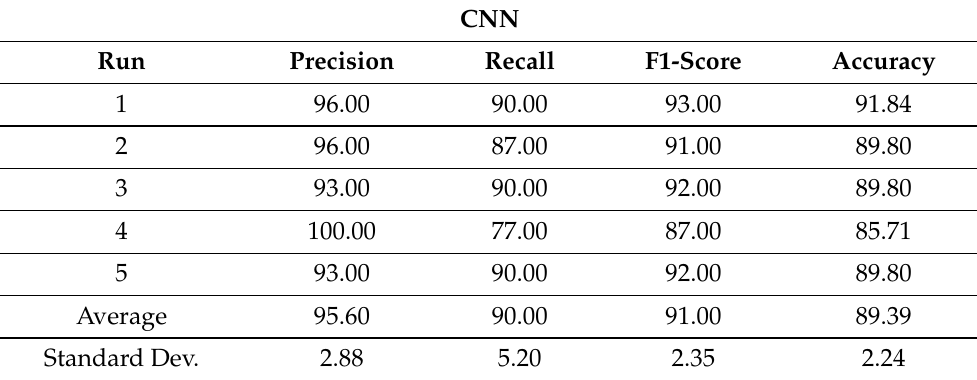
Table 7. Summary of the results obtained with the 1-D CNN model. We collect the test set metrics computed over five different runs. The last two rows report the average over the runs and the corresponding standard deviation.